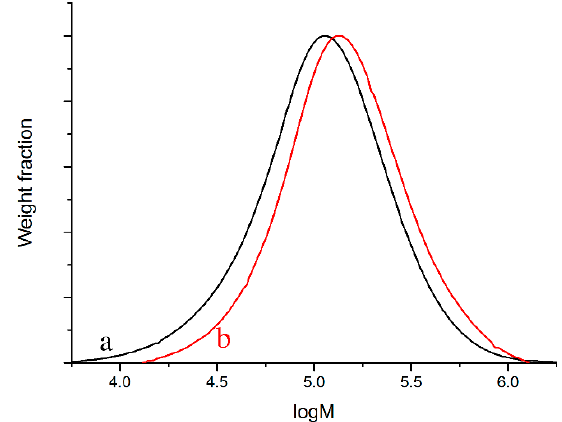
Figure 2. Gel permeation chromatograms (GPC) curves for the samples recorded before ( a ) and after ( b ) the anionic polymerization stages (entry 5, Table 1). ( b ) the anionic polymerization stages (entry 5, Table